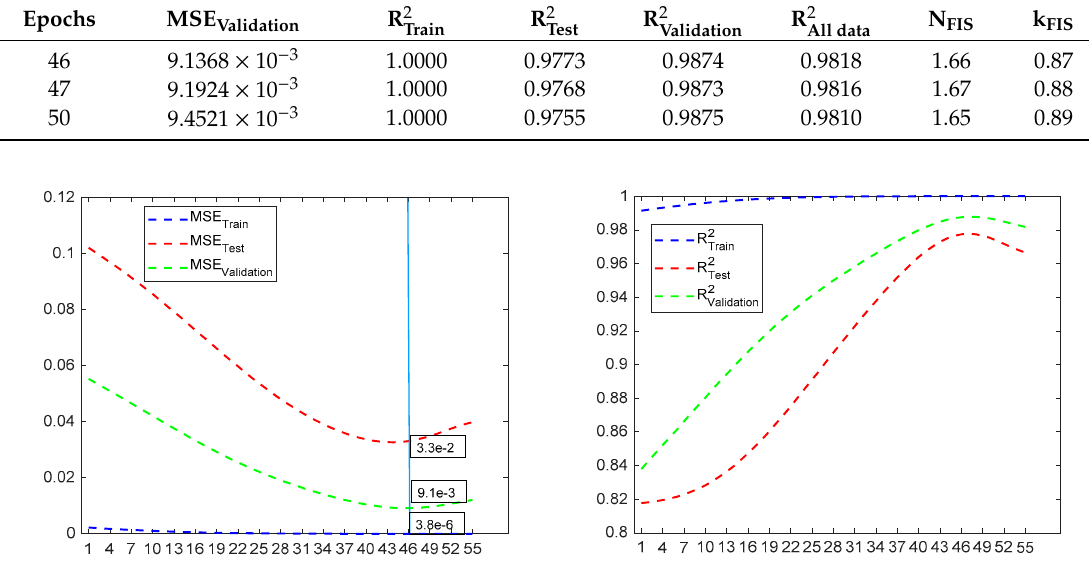
Figure 29. Best MSE and obtained squared-R (Number of Epochs = 46, k FIS = 0.87, N FIS = 1.66 ).